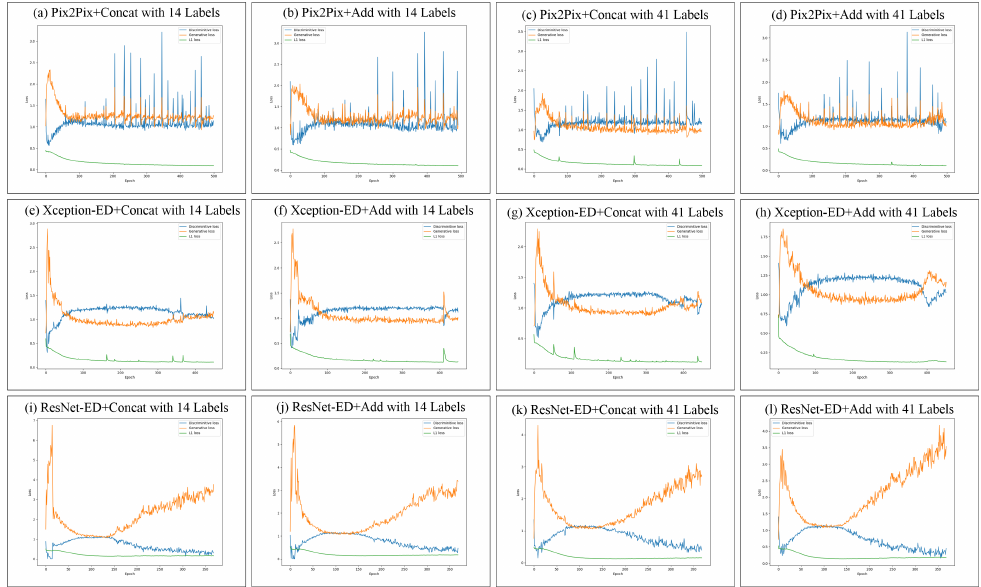
Figure 6. Loss improvement during training on NYU depth V2 dataset for Pix2Pix in ( a – d ), Xception- ED in ( e – h ), and ResNet-ED in ( i – l ) with concatenation and addition as feature merging of the encoder and decoder features with 14 and 41 semantic labels separately.